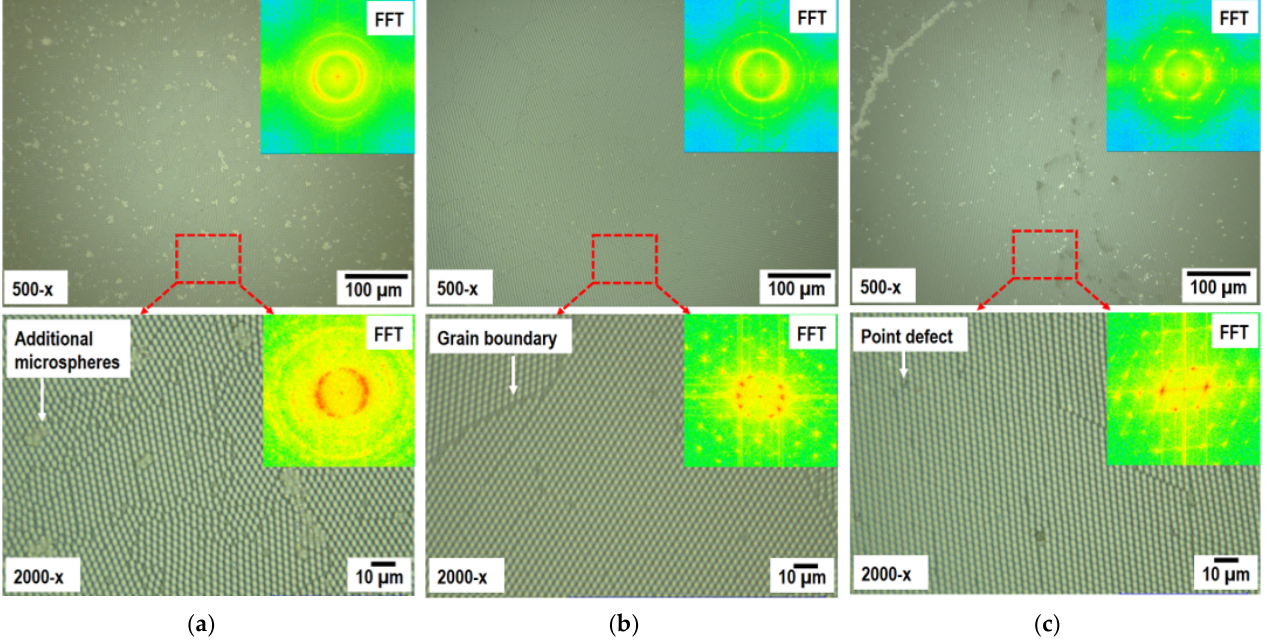
Figure 2. Temperature dependence of the 2D arrangement of polystyrene microspheres (P-spheres) with a 3-micrometer diameter on an Al 2 O 3 -c substrate: ( a ) P-spheres deposited at 20 °C using Langmuir–Blodgett colloidal lithography (LB); ( b ) P-spheres deposited at 25 °C using LB; ( c ) P-spheres deposited at 30 °C using LB. The insert images in Figure 2 represent the Fast Fourier transform (FFT) of the underlaying optical images of the LB results.